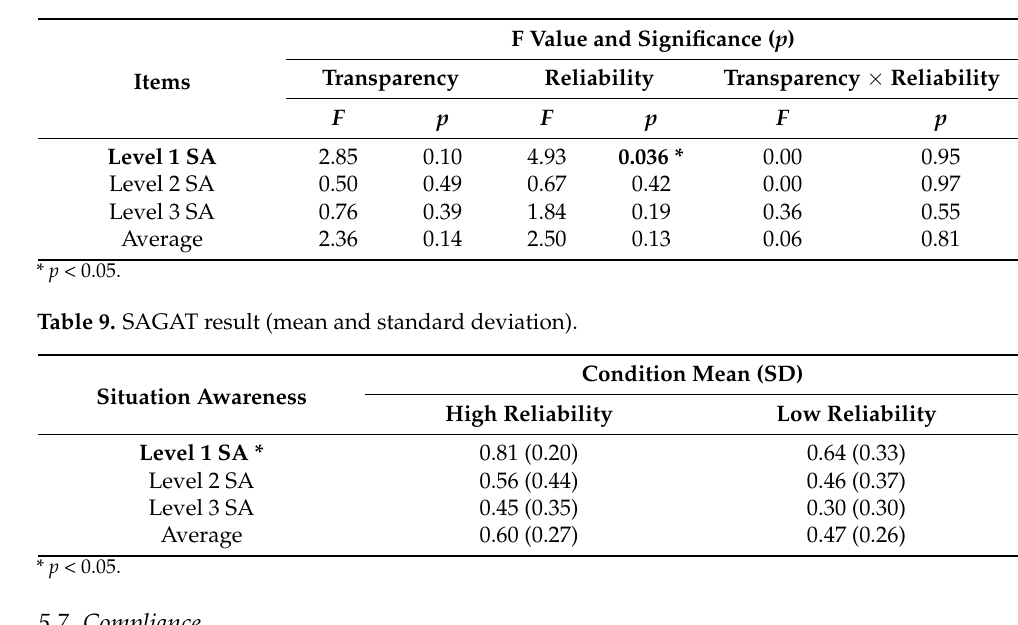
Table 8. Situation Awareness statistics.